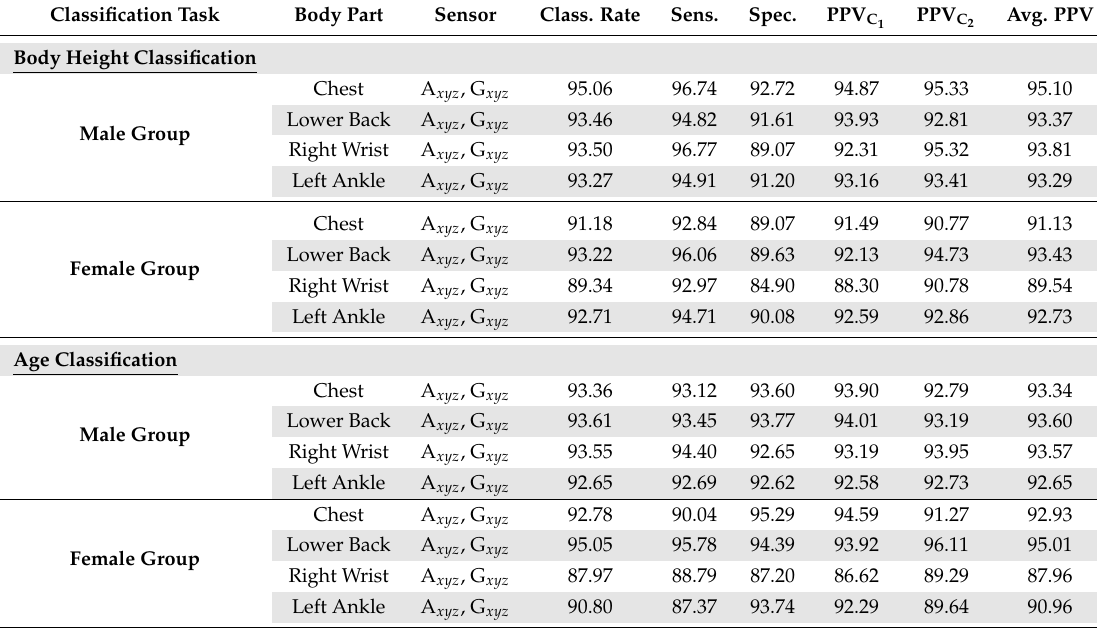
Table 10. Results of body height and age classifications within participant subgroups using 10-fold cross-validation. The results show balanced correct classification rates, sensitivity, specificity, the positive predictive value (PPV) of each class and the average PPV of all classes.